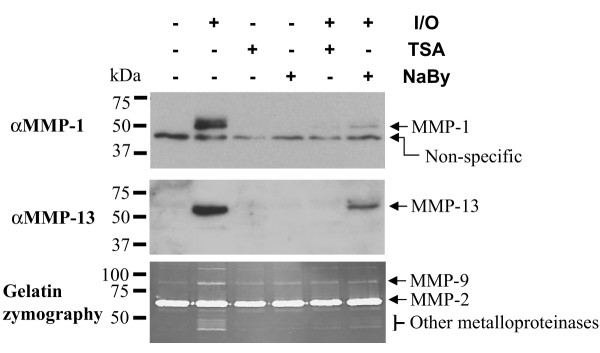
Histone deacetylase inhibitors repress matrix metalloproteinase (MMP) protein expression and activity. Cells were starved of serum for 24 hours before stimulation with I/O, a combination of IL-1α (5 ng/ml) and oncostatin M (10 ng/ml), for 24 hours in the absence or presence of trichostatin A (TSA) (500 ng/ml) or sodium butyrate (NaBy) (10 mM). Conditioned media were subjected to western blot analysis using a rabbit anti-(human MMP-1) antibody or a sheep anti-(human MMP-13) antibody or gelatin zymography, as described in Materials and methods.